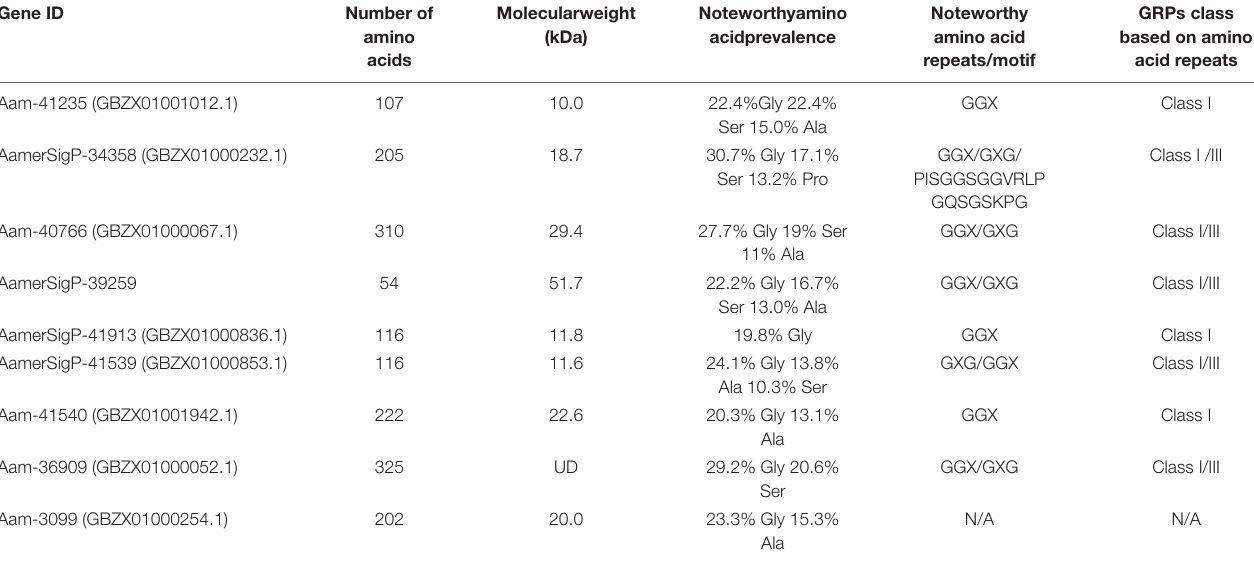
TABLE 1 | Protein characteristics and tripeptide repeats of nine AaGRPS.